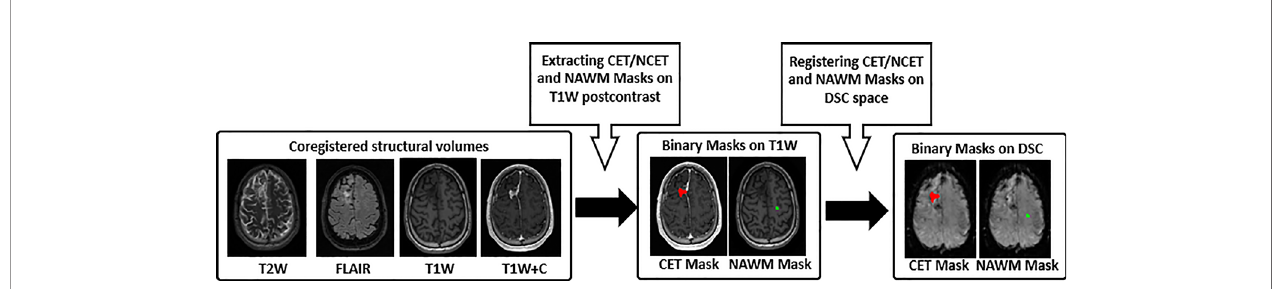
FIGURE 1 | Pre-processing work fl ow. 1) T 2 -weighted (T2W), FLAIR, T 1 -weighted precontrast (T1W) and postcontrast (T1W+C) images used for CET and NCET, and NAWM segmentation, 2) Binary mask of CET/NCET (red color) and NAWM (green color) mask on the structural data, 3) Registered Binary mask of CET/NCET on the third volume of DSC-MR imaging. CET, Contrast Enhanced Tumor; NCET, Non Contrast Enhanced Tumor; NAWM, Normal Appearing White